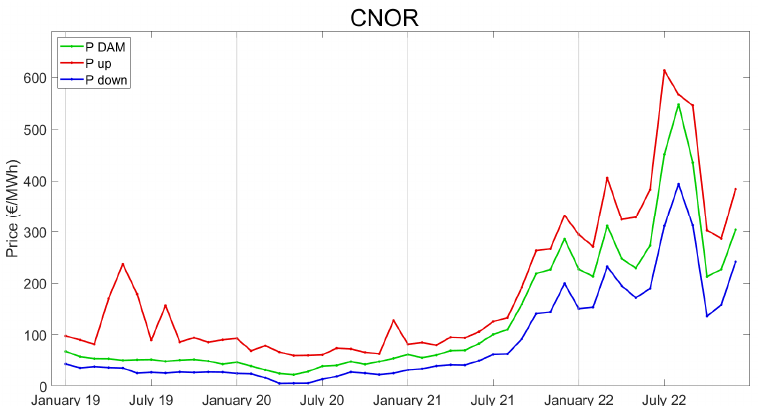
Figure 2. Trend of the average monthly prices of P DAM (green), P up (red), and P down (blue). CNOR market zone; time period from January 2019 to December market zone; time period from January 2019 to December 2022.